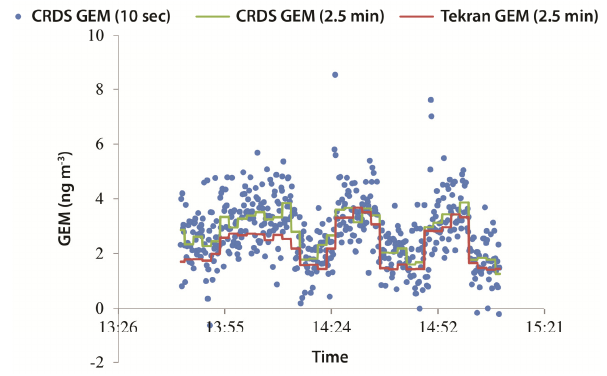
Fig. 7. Ambient air measurement for 1.5h and comparisons of GEM measured by the CRDS system and a Tekran 2537B Hg analyzer (in ngm 3 ) with 1–2ngm − 3 GEM spike additions.